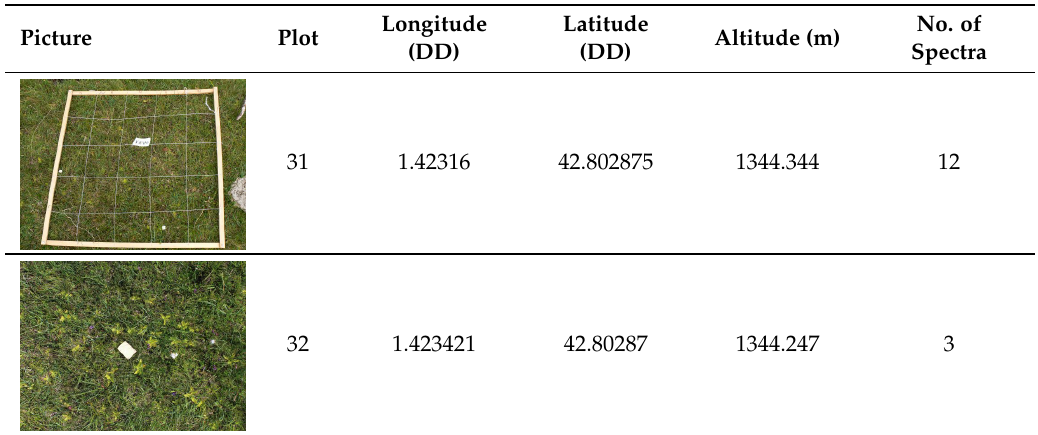
Table A14. Pictures, plots, geographic coordinates and number of spectra of Pinguicula sp. combined vegetation (PI_CV).